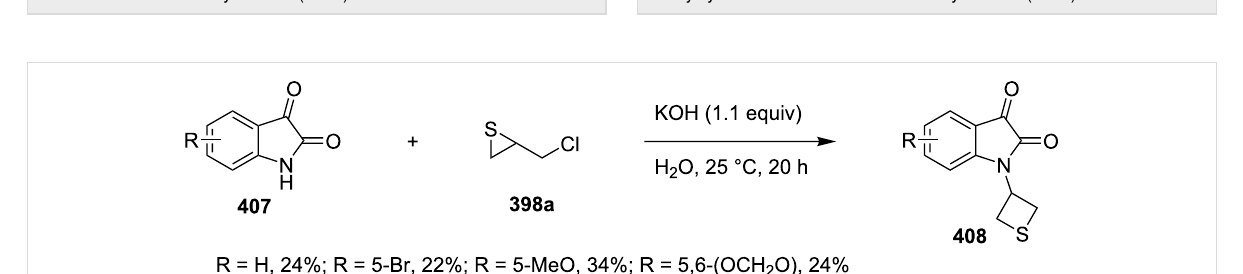
Scheme 89: Synthesis of N -aryl- N -(thietane-3-yl)cyanamides 412 from N -arylcyanamides 411 and chloromethylthiirane ( 398a ).